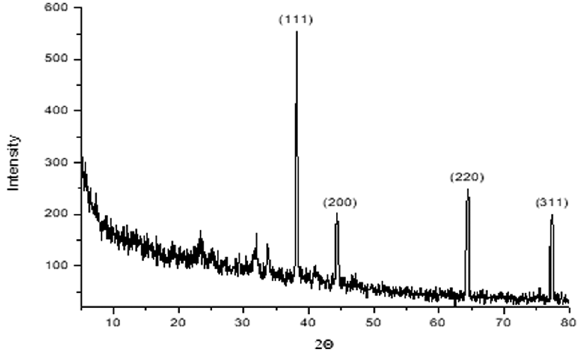
Figure 6: XRD pattern of biologically synthesized silver nanoparticles.